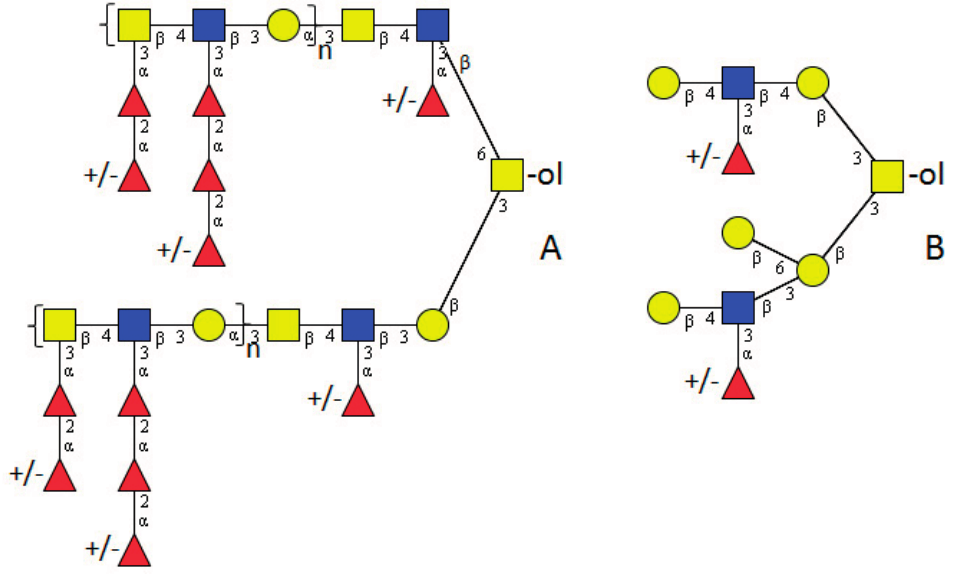
Figure 5. Examples of extended cercariae O- glycans of schistosomes. ( A ) from [70]; ( B ) from